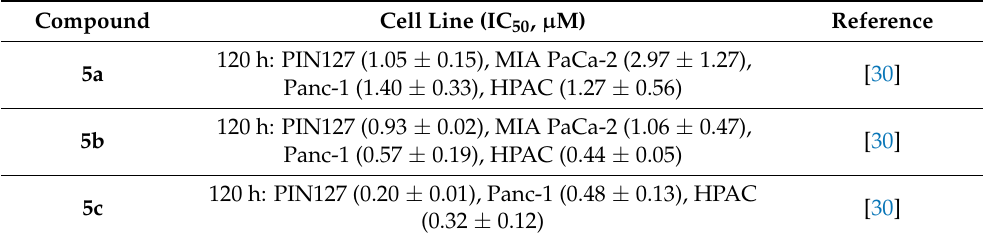
Table 3. IC 50 values of compounds 5a – 5c .